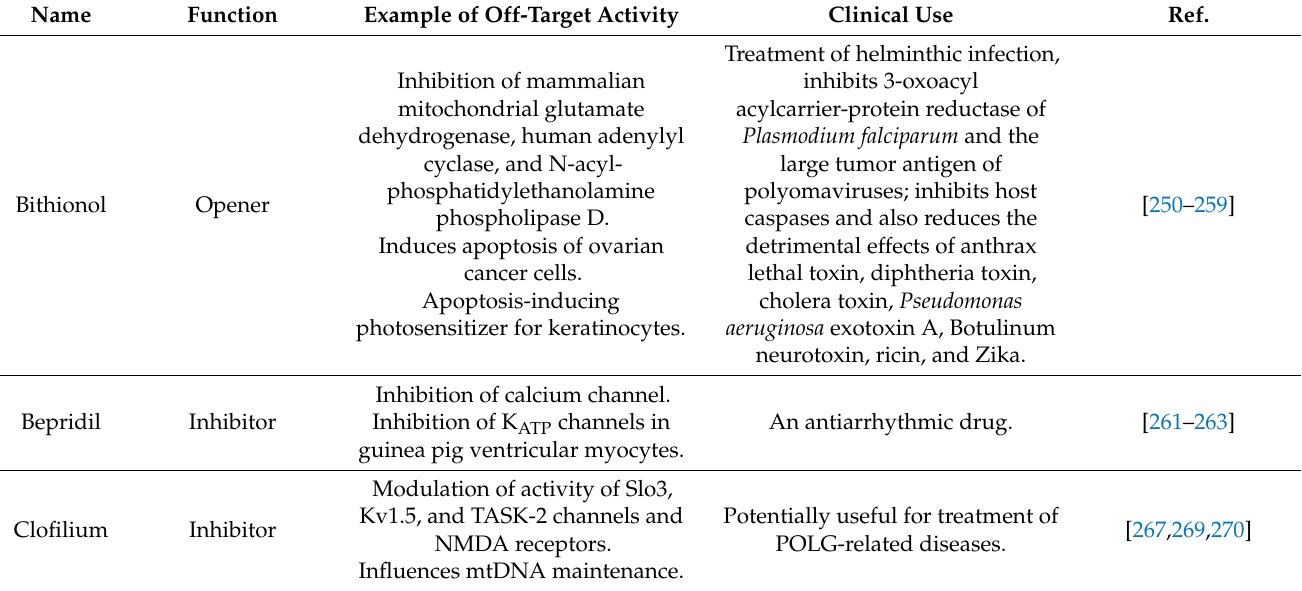
Table 4. Examples of mitochondrial sodium-activated potassium channel modulators and their off-target